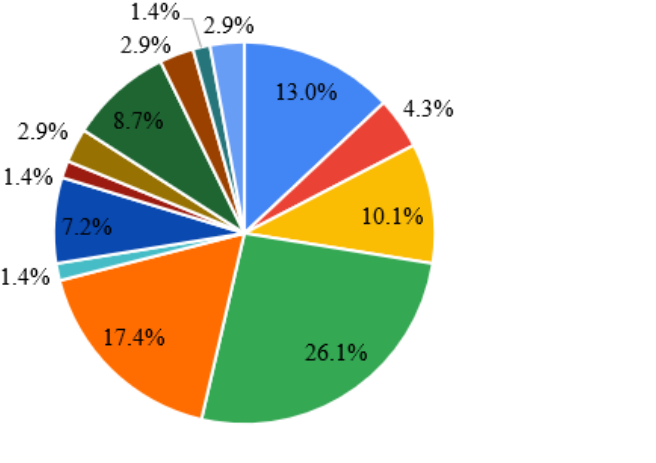
Figure 16. Main applications of Streptomyces